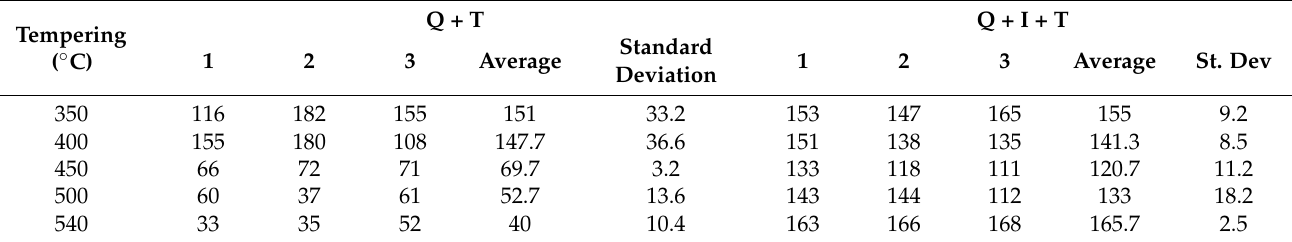
Table 5. Charpy impact toughness.